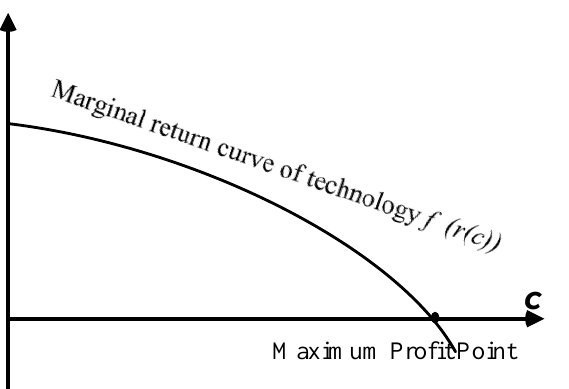
Figure 1. Marginal return curve of technology 𝑓 .